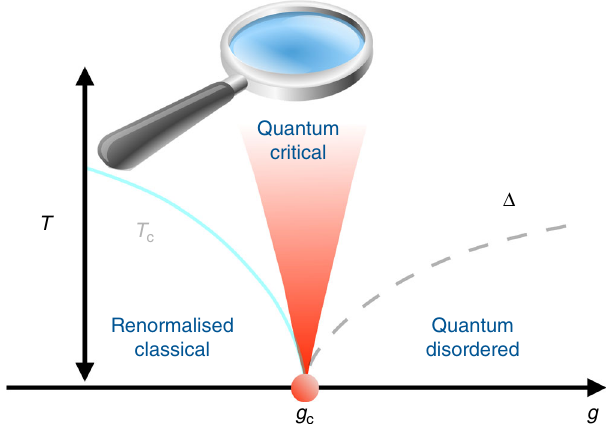
Fig. 1 Quantum critical fan. The quantum critical fan can be seen effectively as a magnifying lens for the quantum critical point, making its existence observable over an extended range of temperatures and of the control parameter g of the